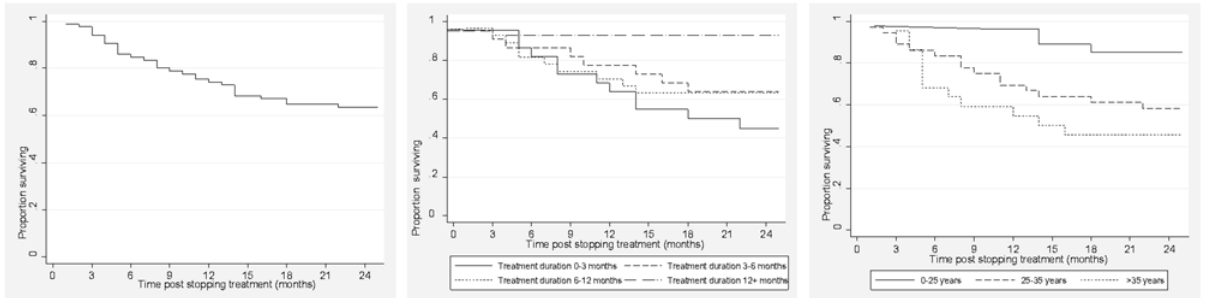
Fig 3. Survival post treatment: Overall, Duration of treatment before LFT, and Age at DR-TB